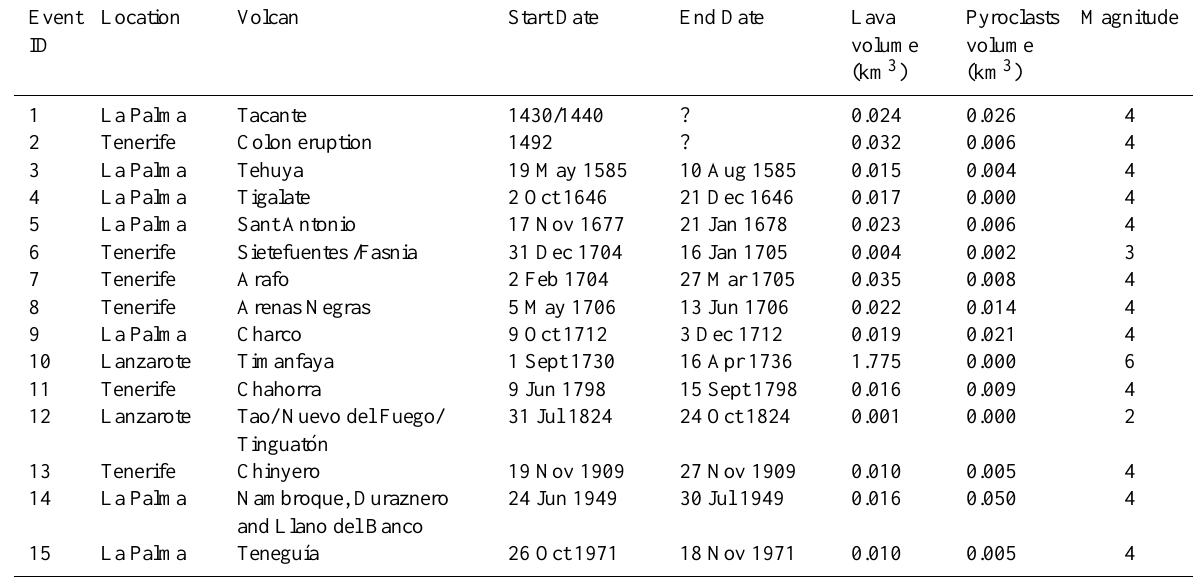
Table 2. Volcanic Eruptions dataset used in the study for the volcanic hazard assessment of the Canary Islands. Event